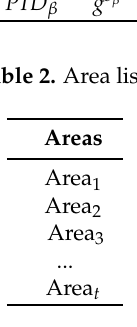
Table 3. Private key list.